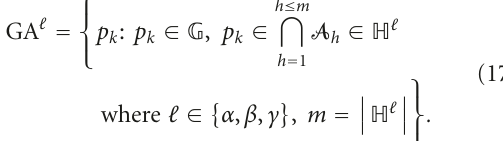
Figure 1: Example of perimeter